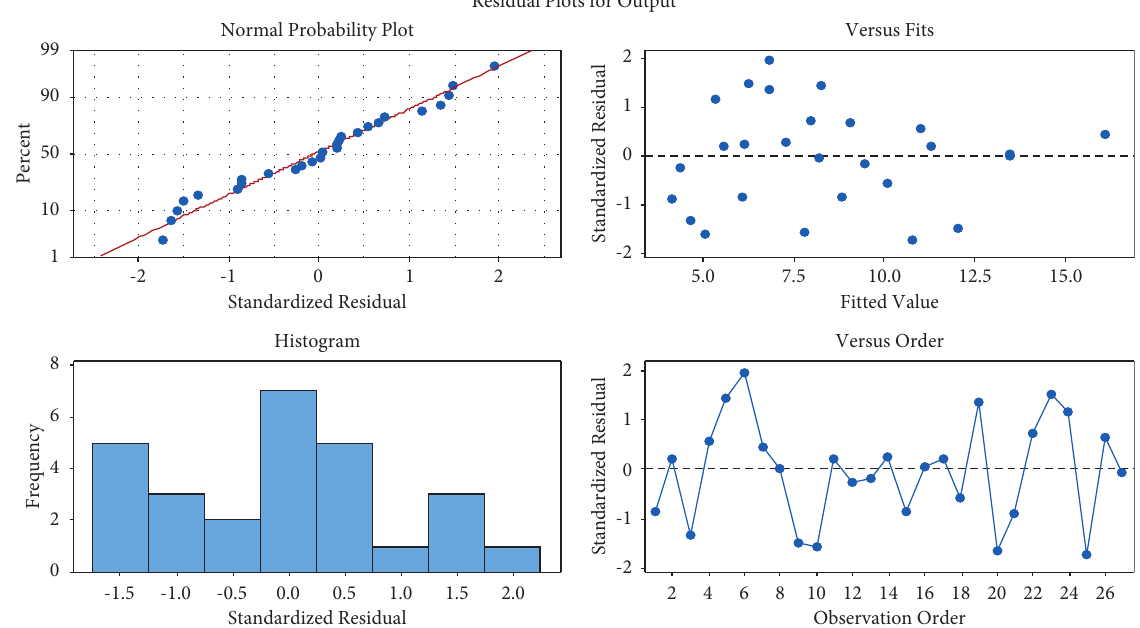
Figure 8: Residual plot output on dry sliding wear test.